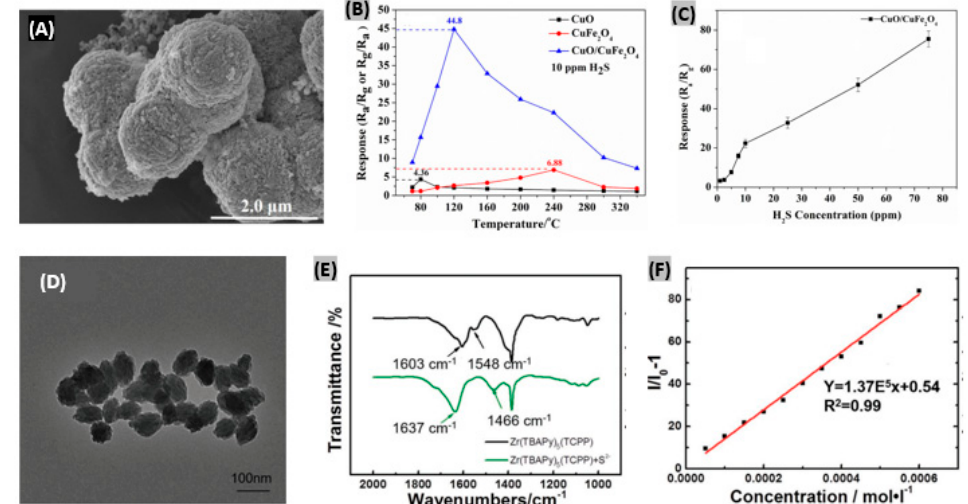
Figure 14. ( A ) FE-SEM image of synthesized CuO/CuFe 2 O 4 heterostructure. ( B ) Variation of gas sensing responses of CuO microspheres, CuFe 2 O 4 nanoparticles and CuO/CuFe 2 O 4 heterostructure with working temperatures. ( C ) H 2 S concentrations dependent sensing responses of CuO/CuFe 2 O 4 sensor at 240 °C. Figures adapted with permission from [171], Copyright 2018 Elsevier. ( D ) TEM image of the synthesized Zr(TBAPy) 5 (TCPP). ( E ) FTIR spectra of Zr(TBAPy) 5 (TCPP) before and after H 2 S exposure. ( F ) Fluorescent enhancement response of the fabricated sensor under increasing S 2